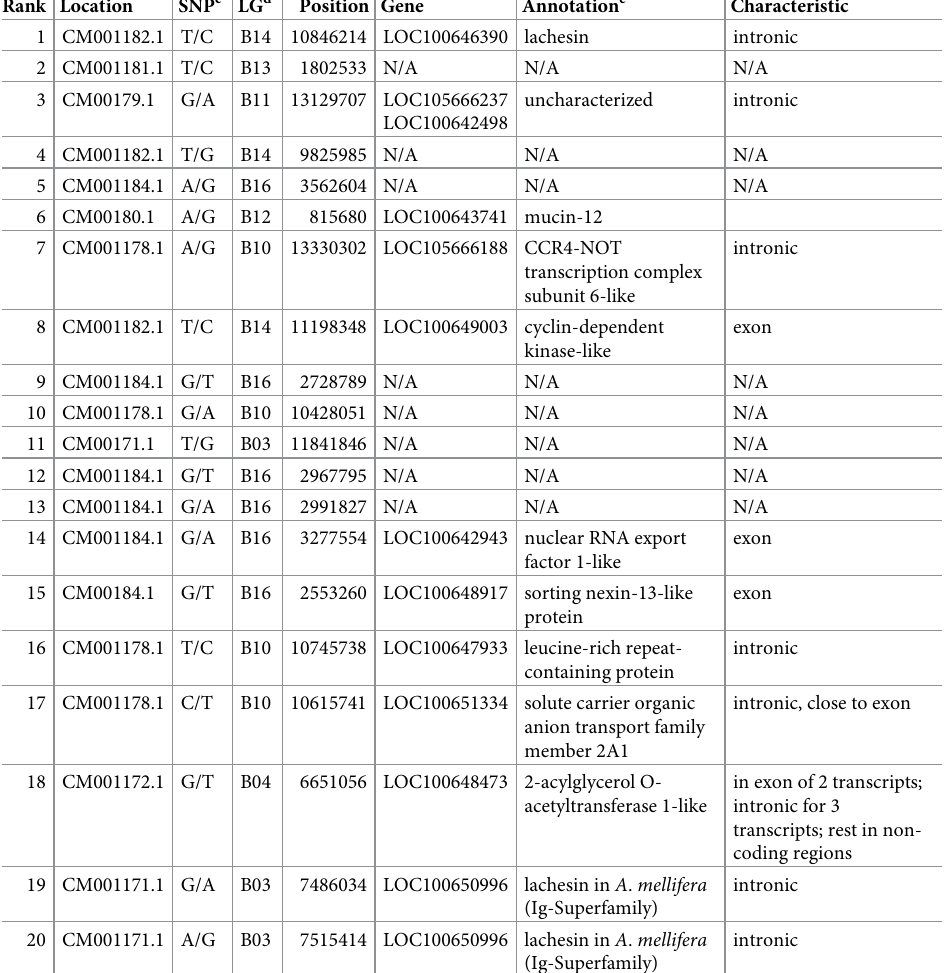
Table 5. Top 20 SNPs associated with infection intensity in samples having Axis.1 �